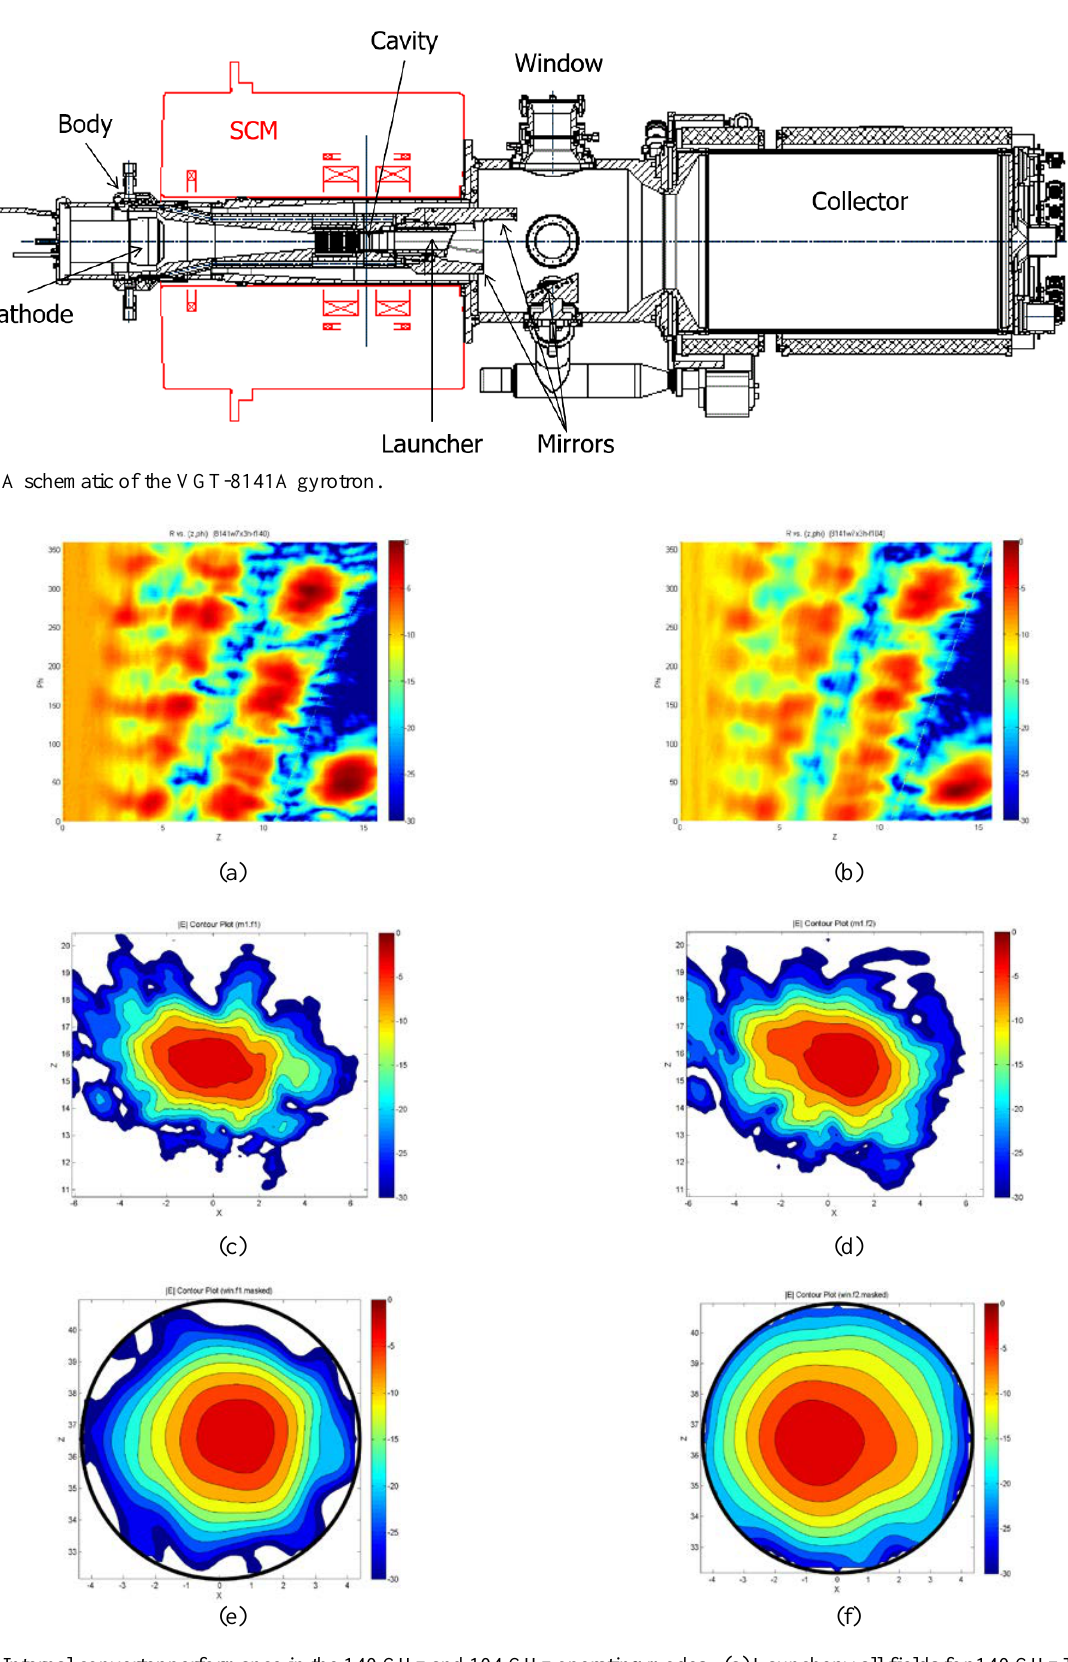
Fig. 3. Internal converter performance in the 140 GHz and 104 GHz operating modes. (a) Launcher wall fields for 140 GHz TE 28,7 . (b) Launcher wall fields for 104 GHz TE 22,5 . (c) Fields on Mirror 1 at 140 GHz. (d) Fields on Mirror 1 at 104 GHz. (e) Fields on Output Window at 140 GHz. (f) Fields on Output Window at 104 GHz. Color scales are dB. Linear dimensions are cm. Angular dimensions are